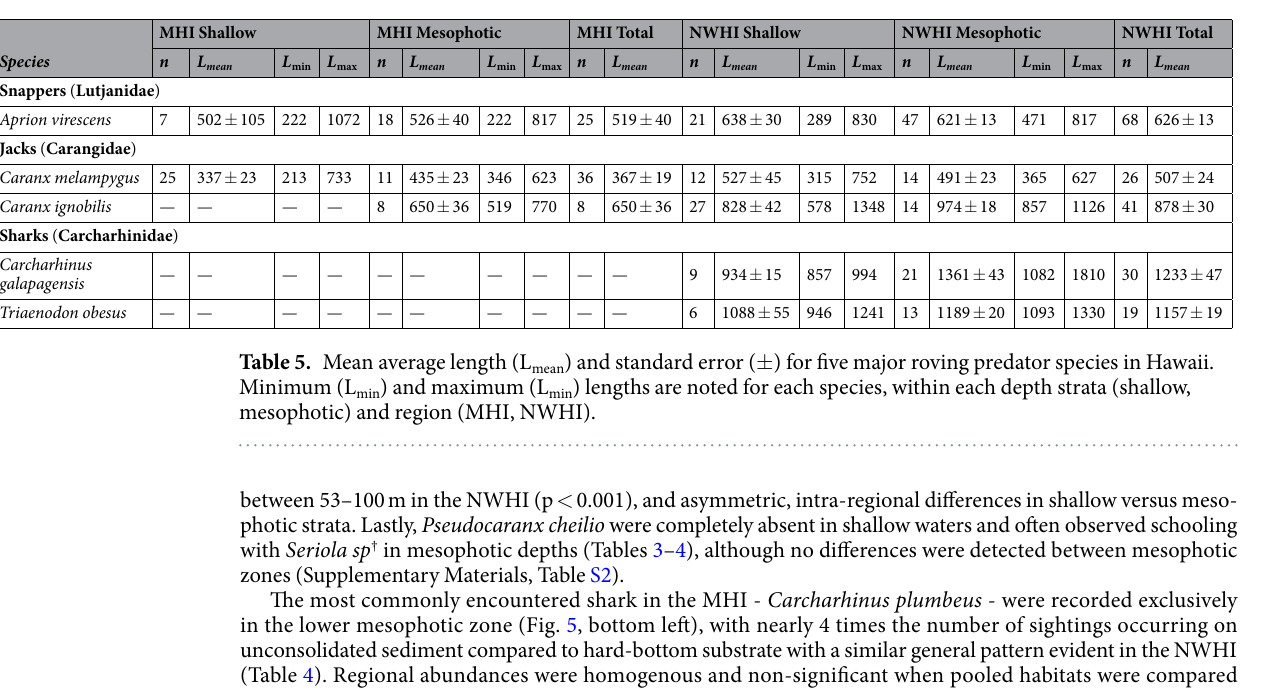
11 Scientific RepoRts | 7: 3905 | DOI:10.1038/s41598-017-03568-1